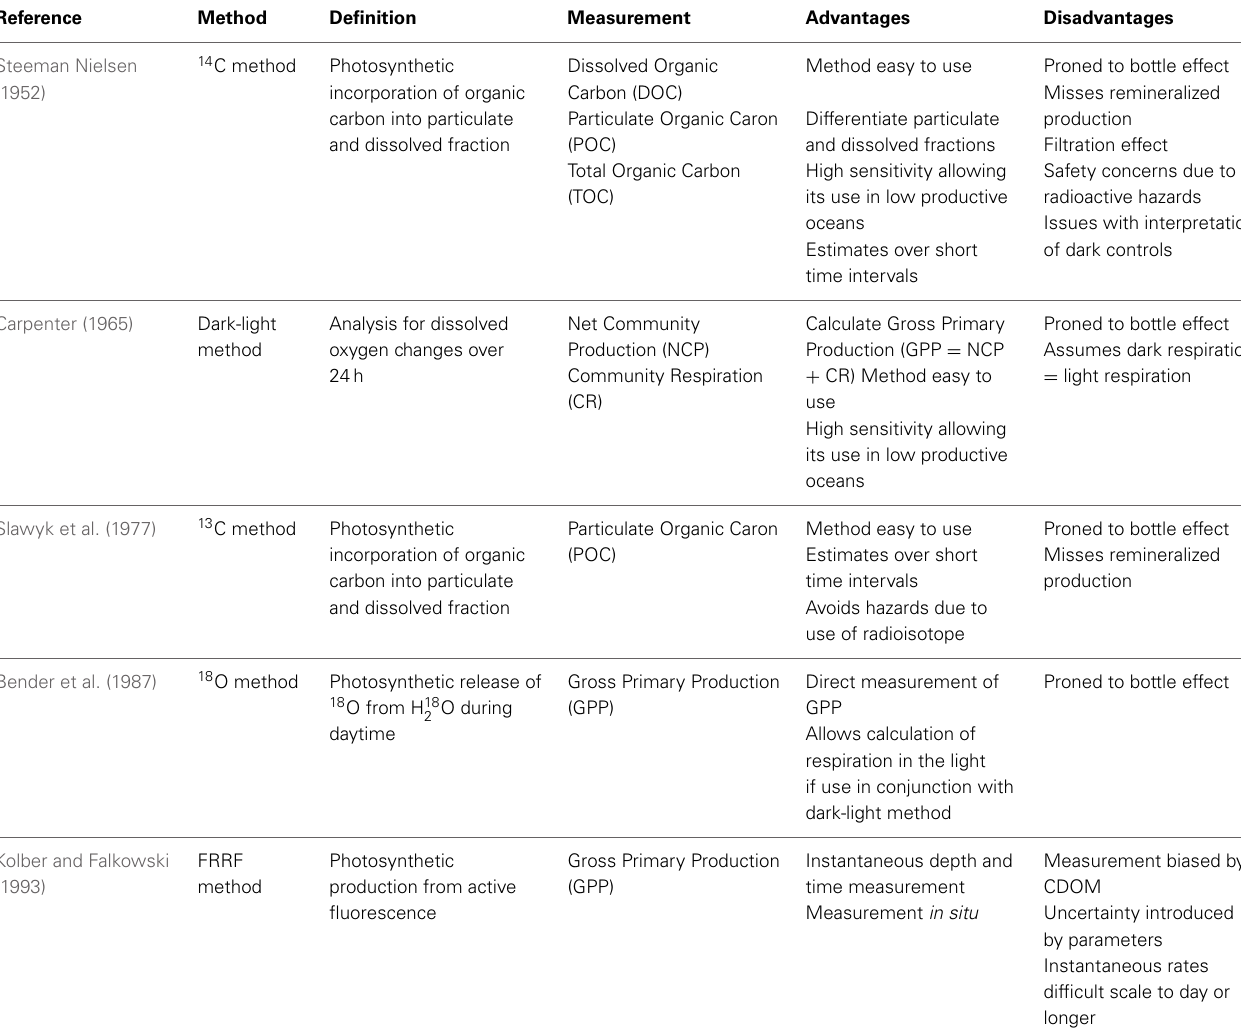
Table 1 | Summary of the main characteristics, advantages, and limitations of different approaches measuring volumetric phytoplanktonic primary